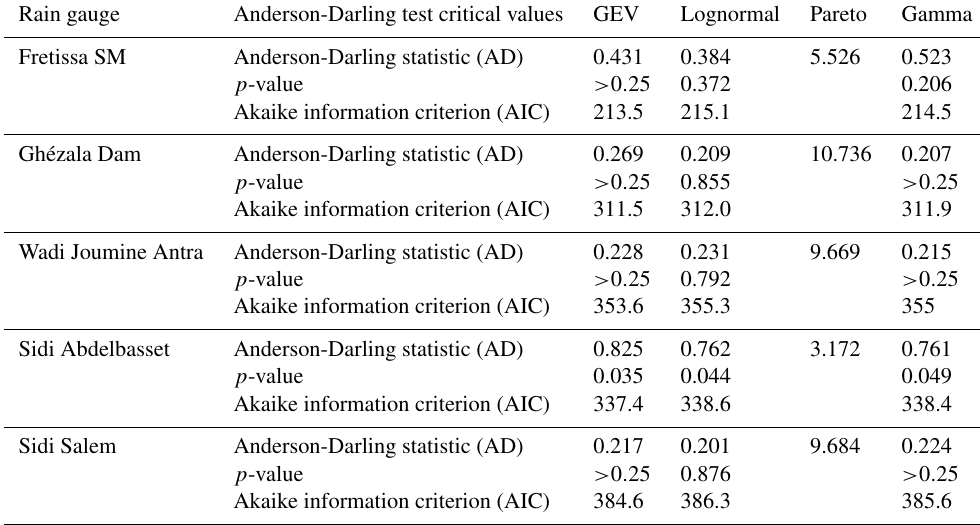
Table 4. Maximum likelihood estimation of the Anderson-Darling statistic for Ichkeul lake basin. Rain